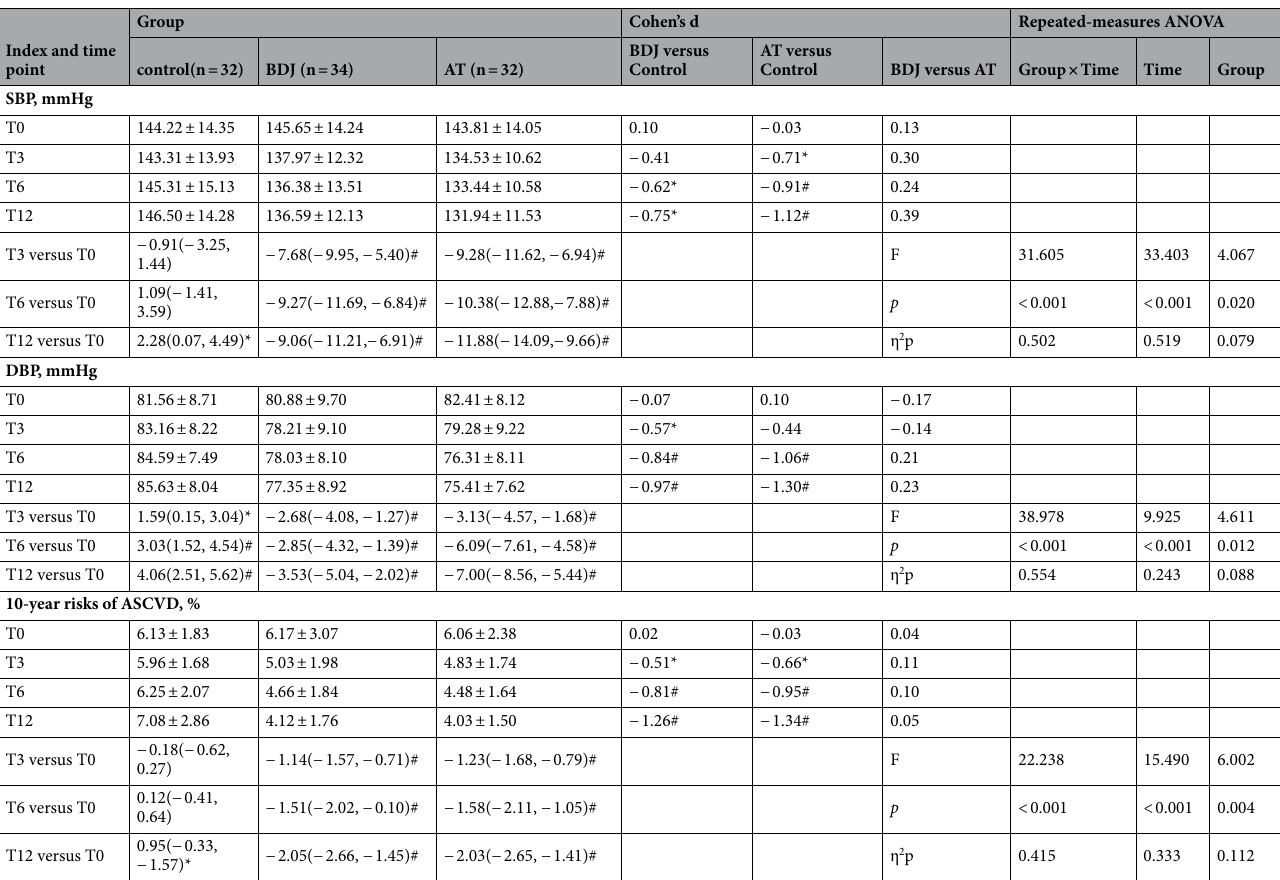
Table 5. Effects of interventions on BP and 10-year risks of ASCVD among the three groups [mean ± SD or mean difference (95% CI)]. BDJ, Baduanjin; AT, aerobic training; SBP, systolic blood pressure; DBP, diastolic blood pressure; ASCVD, atherosclerotic cardiovascular disease; η 2 p, partial eta-squared; T0, baseline; T3, at